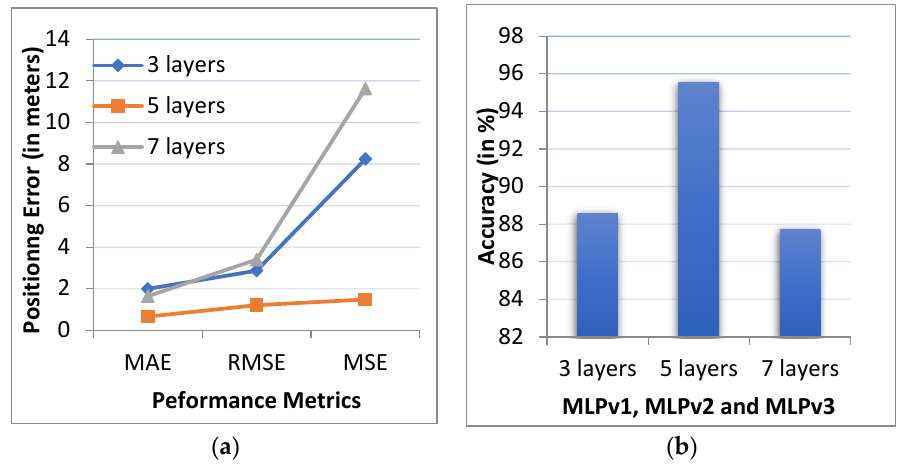
Figure 9. Comparison of: ( a ) the positioning error (MAE, MSE and RMSE) and ( b ) the accuracy for the number of the layers of the model.